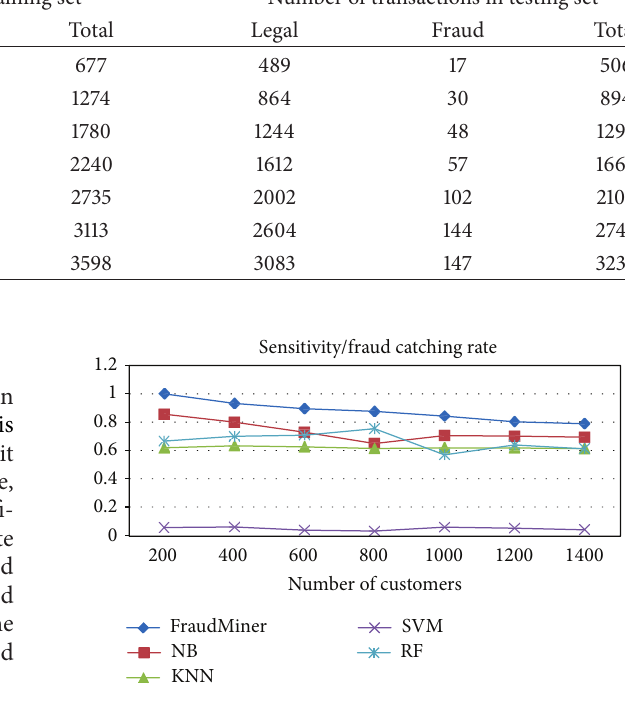
Figure 2: Performance comparison of classifiers on